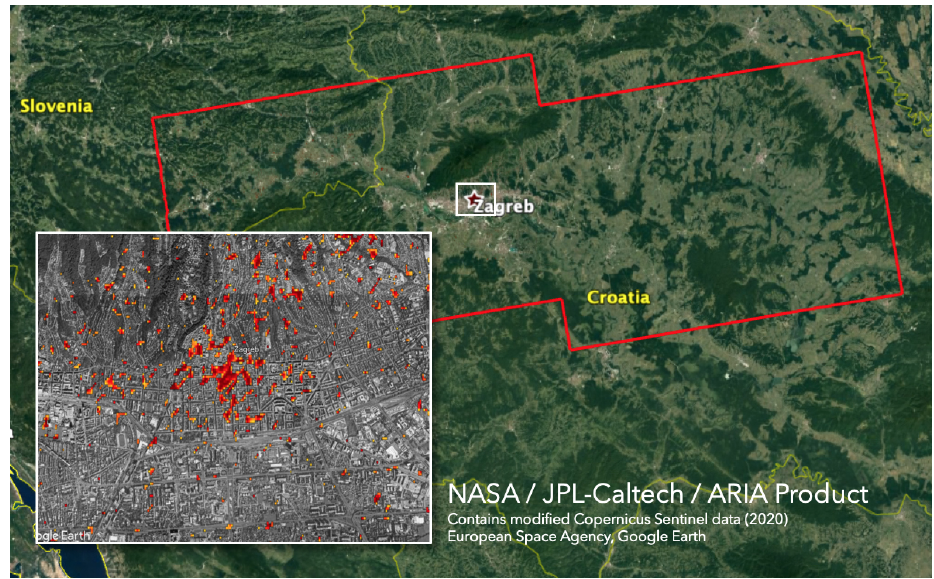
Figure 1. DPM for the March 2020 Zagreb earthquake (contains modified Copernicus Sentinel data and © Google Earth 2020 imagery, processed by